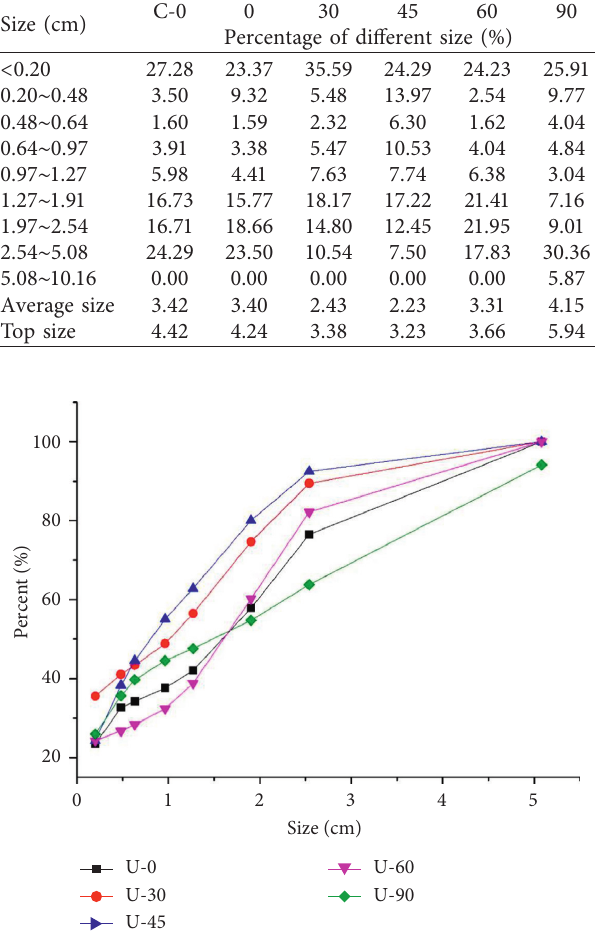
Figure 13: The fragmentation size distribution of granite speci- mens with different flaw